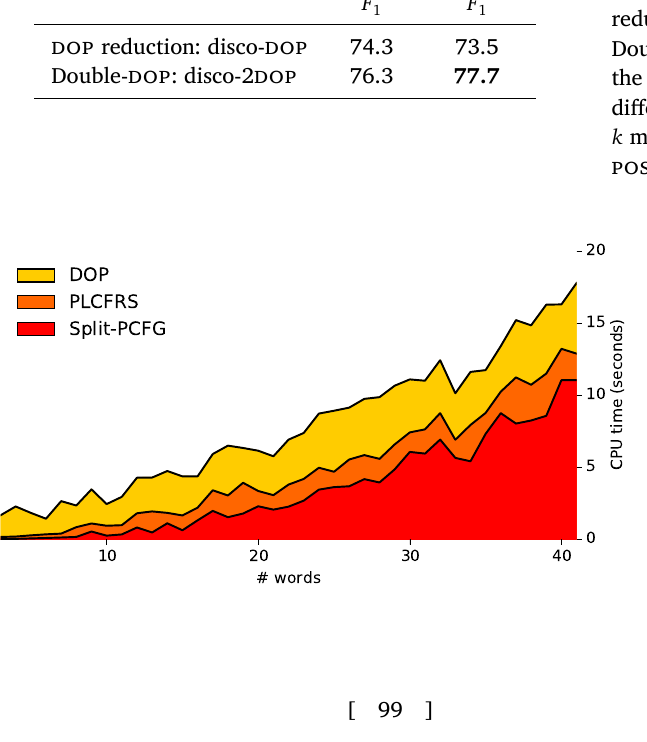
Comparing F-scores for the dop